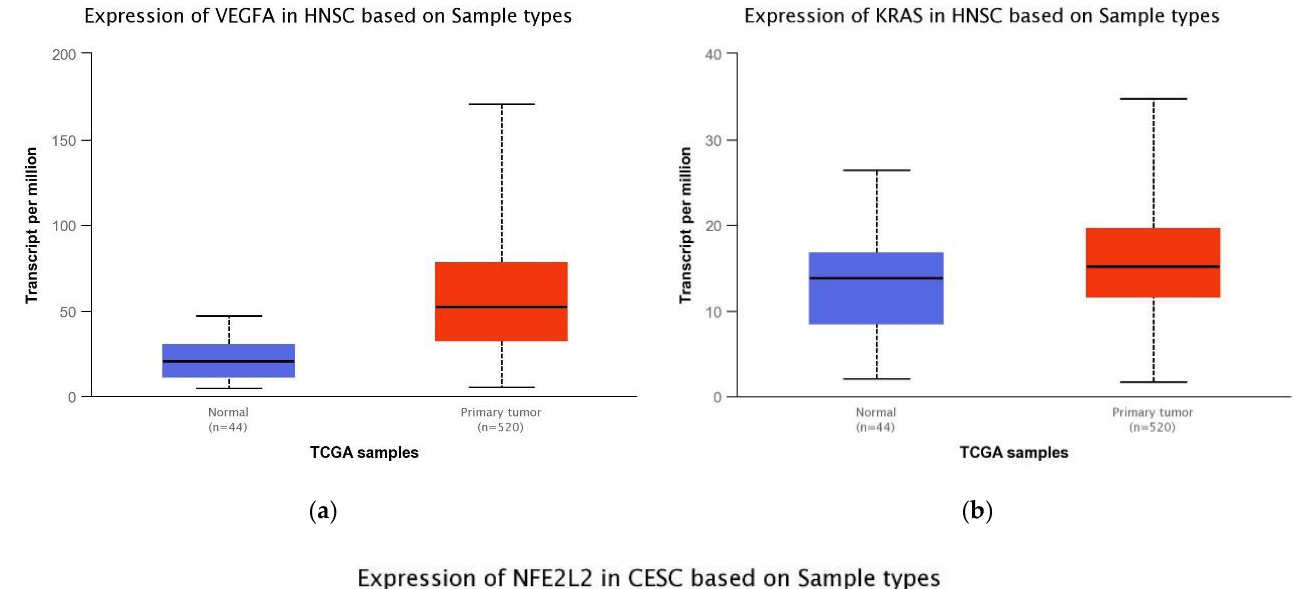
Table 1. Mean relative quantification (RQ) of microRNAs miR-17-5p, miR-140-5p, and miR-874-3p after transfection in HNC cell lines.